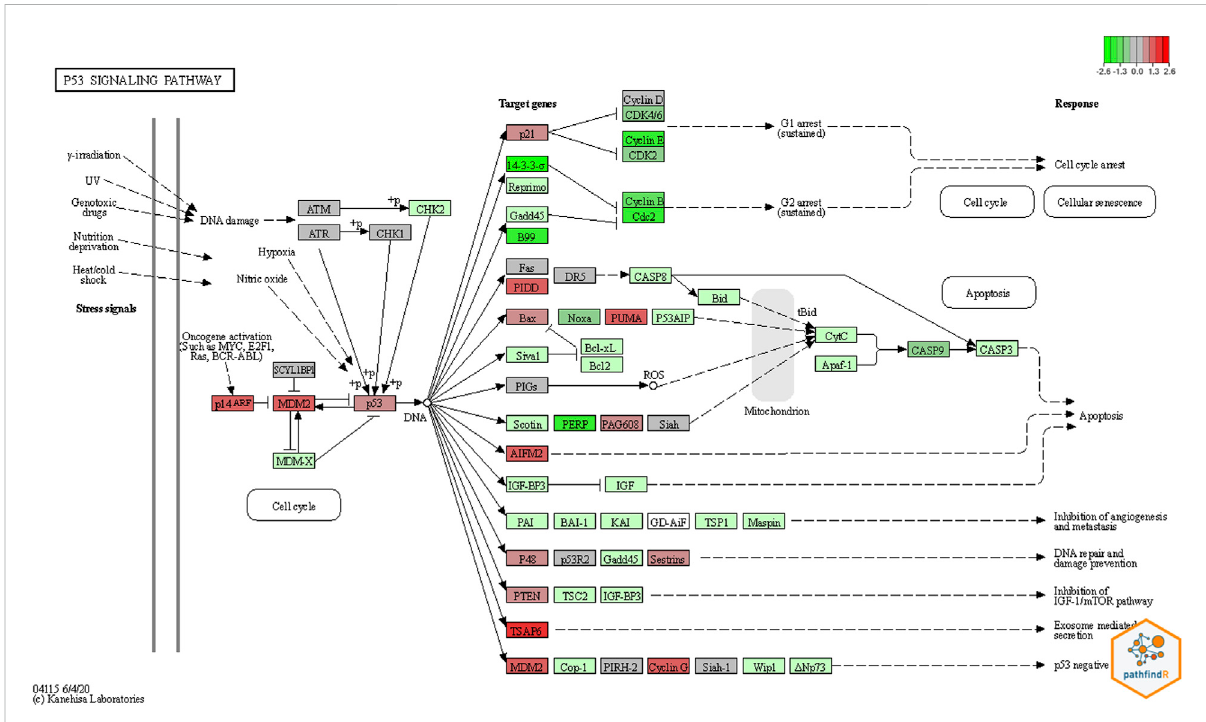
FIGURE 4 Pathway Result by path fi ndR . The colored plot was generated based on KEGG pathway diagrams through path fi ndR . Red colors represent upregulated genes, and green colors the down regulated genes. In thisplot for theTP53pathway, MDM2 which is theprincipal negative regulator of the pathway, was signi fi cantly